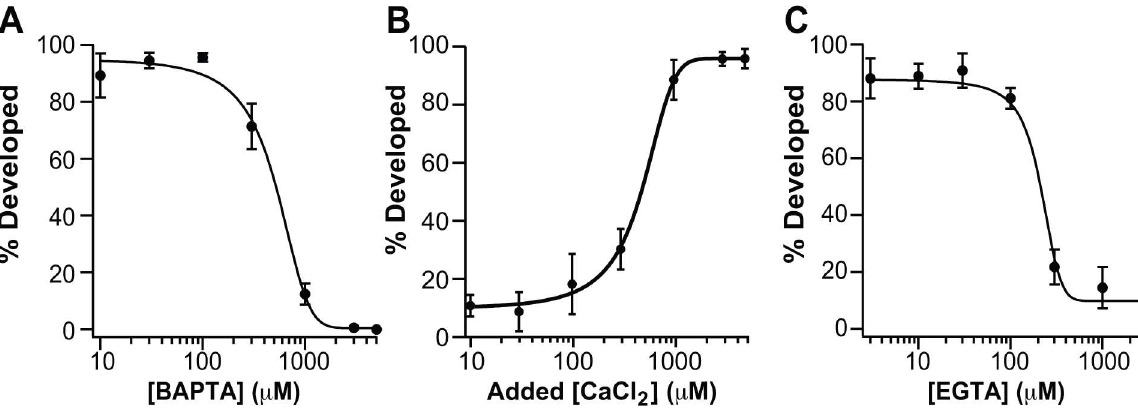
Fig 2. Extracellular Ca 2+ is required for early embryonic development in X . laevis . Plots of averaged percentageof embryosthat developed from eggsinseminatedin DVF/3 with increasingchelatoror CaCl 2 concentrations. Each plot was fit with a sigmoidalfunction. (A) BAPTA concentrations rangedfrom 10 μ M—5mM (N = 71–190eggs in 3–5 experimental trials). (B) Varyingconcentrations of